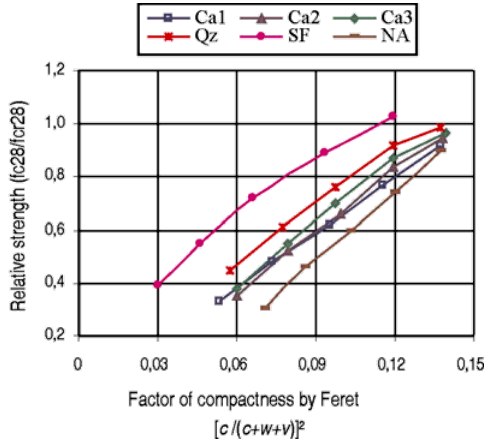
Fig 7. Evaluation of the relative compressive strength in 28 days according to the factor of compactness [( c /( c + w + v )]